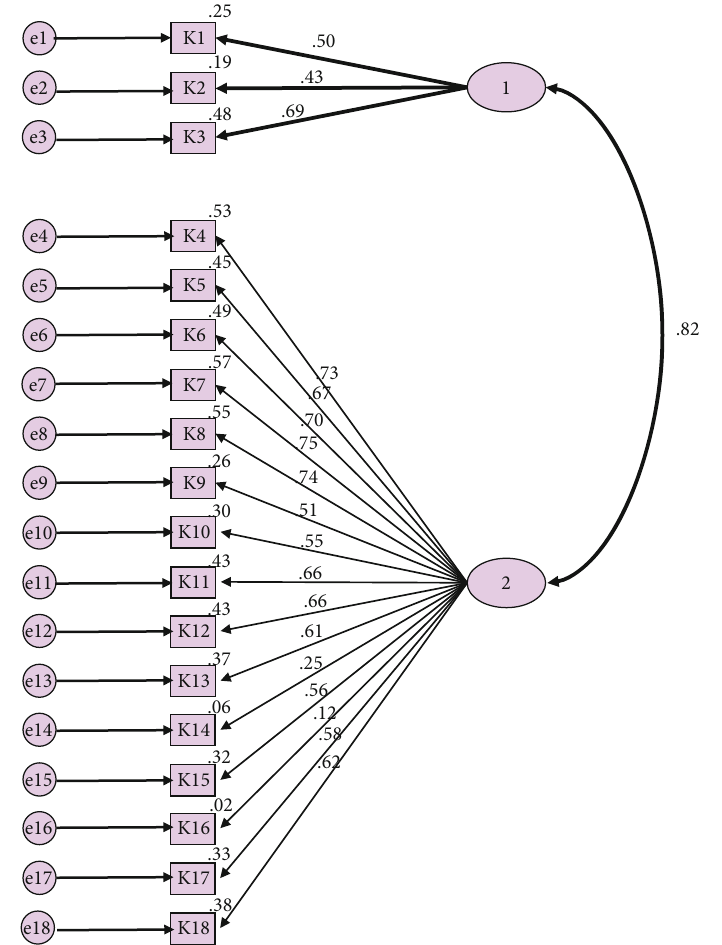
Figure 2: Con fi rmatory factor analysis